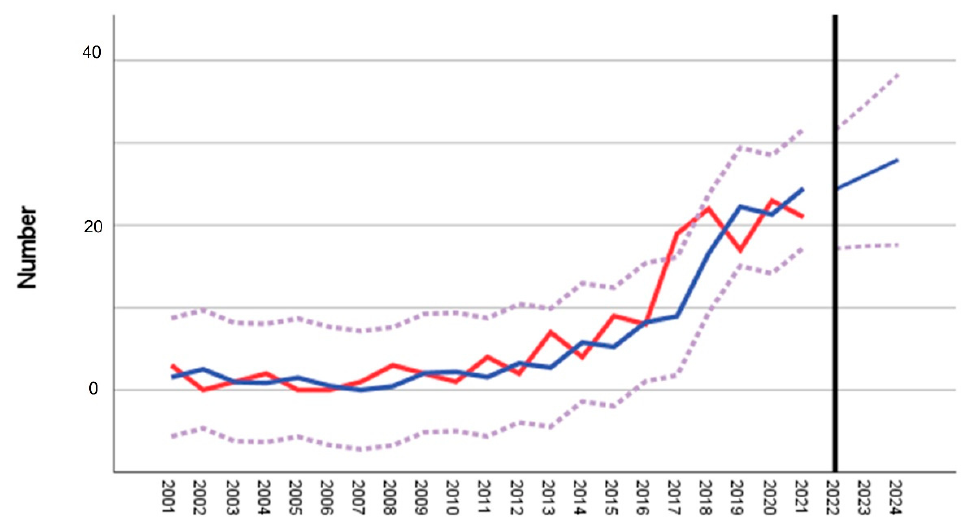
Figure 2. Number of notified human TBE cases spanning the 2001–2021 time period in the district of particular interest: Ravensburg forecasting the years 2022–2024. The red line indicates the notified number of cases, while the blue line indicates the forecasting curve (R 2 = 0.819). The upper and lower limits of 95% confidence intervals are shown as dotted lines.